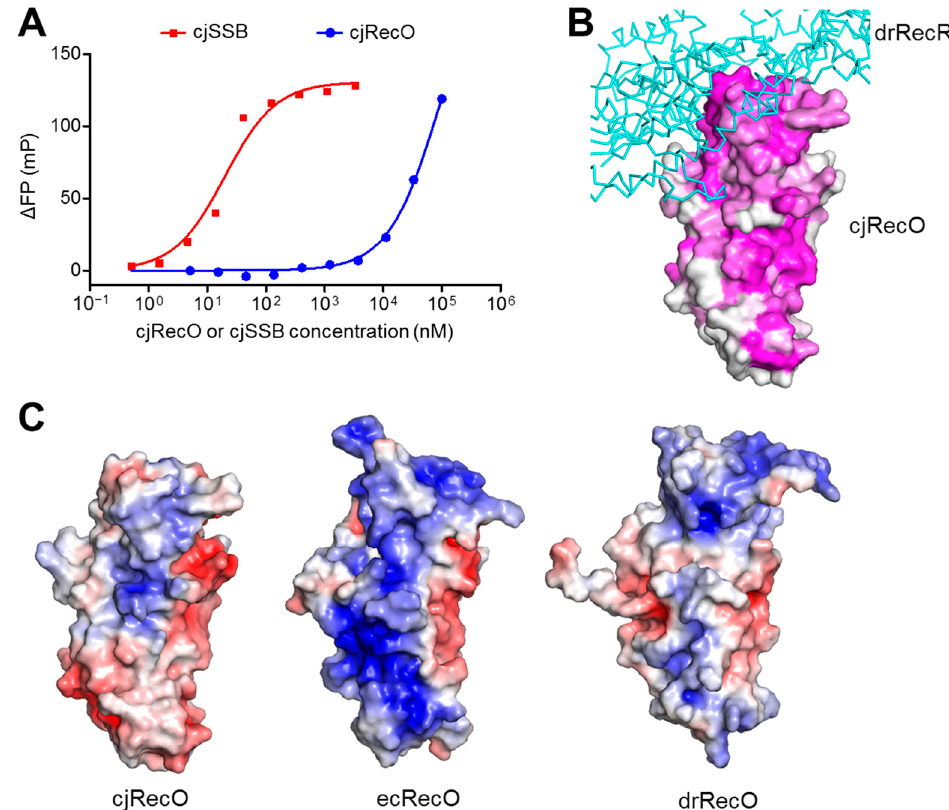
Figure 5. ssDNA binding by cjRecO. ( A ) Interaction of cjRecO and cjSSB with ssDNA identified by the FP assay. The data are representative of three independent experiments that yielded similar results. ( B ) Sequence conservation of RecO proteins on the cjRecO structure. The cjRecO structure is shown as surfaces that represent the sequence conservation of cjRecO orthologs (high sequence conservation, magenta; low sequence conservation, white). To show the putative RecR-binding regions of cjRecO, the drRecR structure from the drRecO-drRecR complex (PDB ID 4JCV) is shown as cyan C α traces with the cjRecO structure. The orientation of cjRecO is identical to that shown in the right side of Figure 1A. The backside view of the figure is shown in Figure S4. ( C ) Electrostatic potential surfaces (positive, blue; neutral, white; negative, red) of cjRecO (left panel), ecRecO (middle panel; PDB ID 3Q8D), and drRecO (right panel; PDB ID 1U5K).